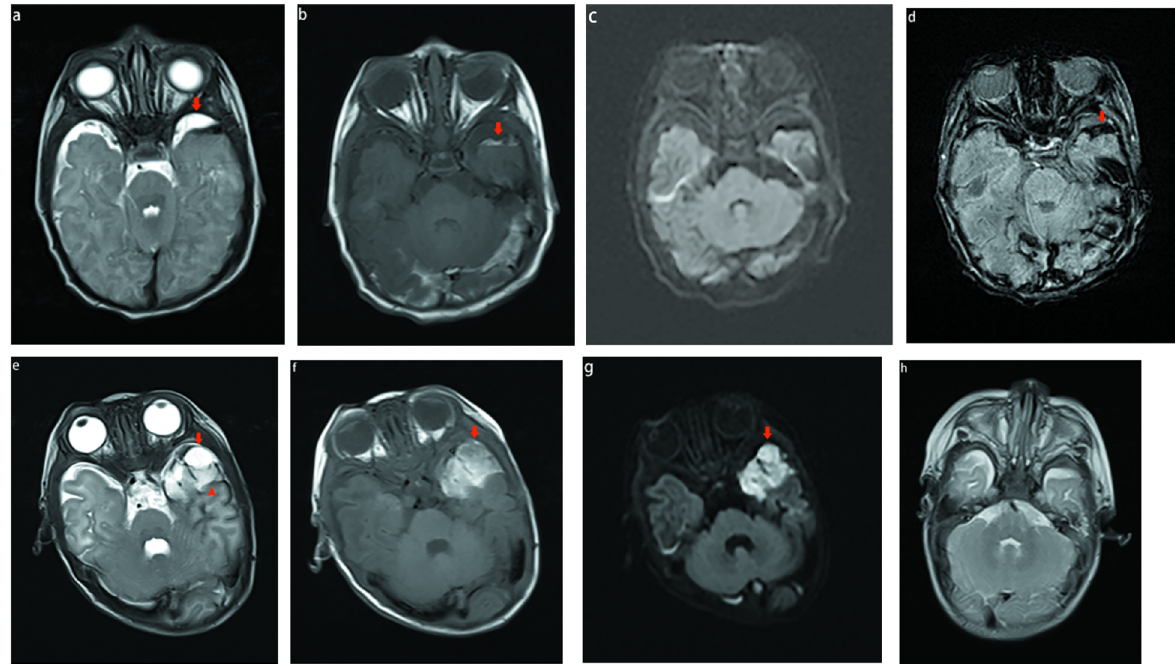
Figure 1. MR images of 2 full-term neonates with pattern A. In the first patient ( a – d ), the subpial hemorrhage shows hepointense on T2WI ( a ), hyperintense on T1WI ( b ), no restricted diffusion ( c ), and hypointense signal on SWI ( d ). The combination of a dark or bright subpial hemorrhage collection and the normal underlying cerebral cortex forms a yin-yang symbol ( a – b ). In the second patient ( e – g ), the subpial hemorrhage shows hyperintense on T1WI and T2WI, with restricted diffusion ( g ). On T2WI ( e ), we found a thin layer of additional hypointense fluid in the deep aspect between hemorrhage and the cortex (arrowhead), the presence of a bright subpial bleed, a dark, thin layer of fluid and an underlying normal cortex-created sandwich sign. The first patient received MRI examination after 3 months; The subpial hemorrhage was completely absorbed and the cerebral sulcus fissure widened ( h ).